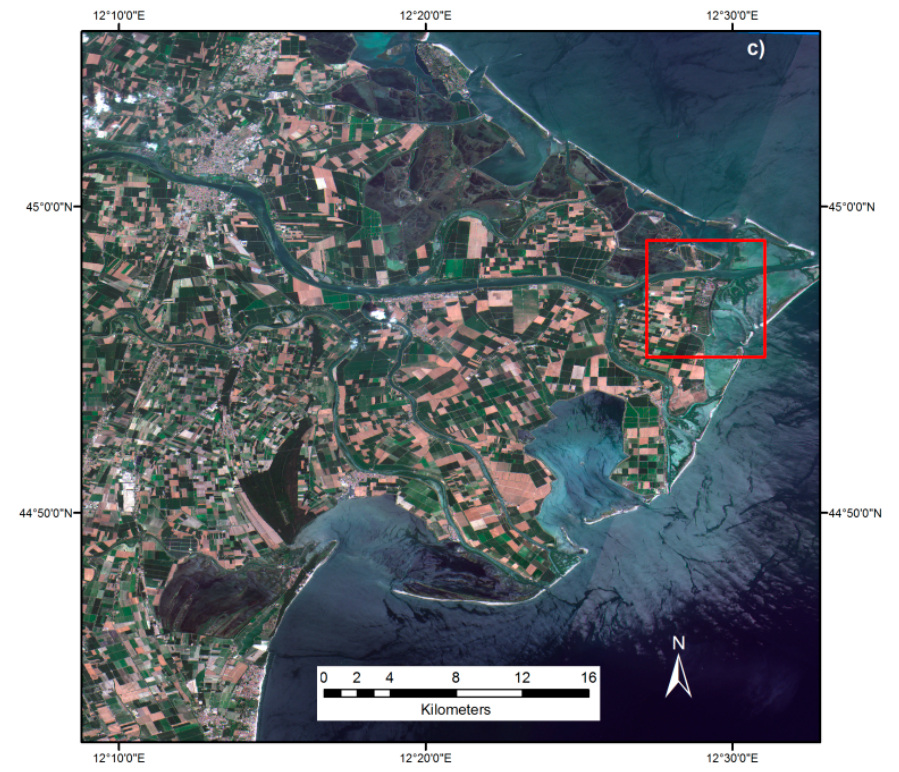
Figure 4. ( a ) Close-up view of the CLC training; ( b ) classified Sentinel-2; and ( c ) the original Sentinel-2 image in natural colors.